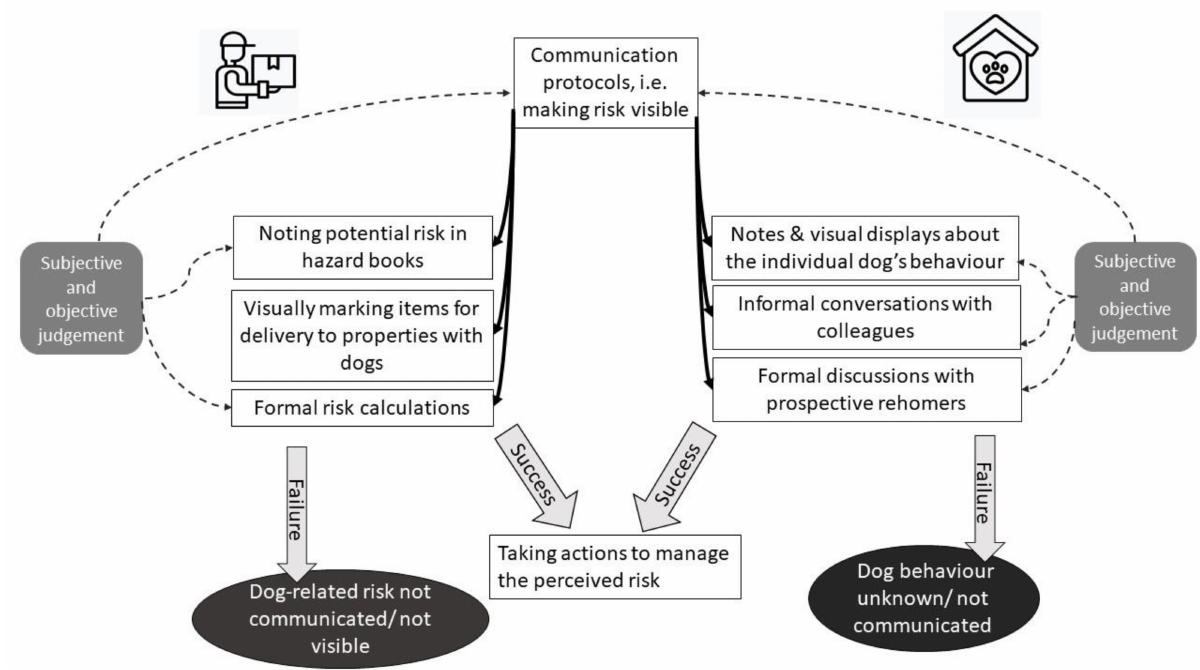
Figure 3. Schematic representation of the second step of dog bite prevention: communicating risk to others. In both delivery companies and dog shelters communication protocols rely on subjective and objective judgement of risk, however the specific protocols for communication differ between the organisations. Successful communication enables taking actions to manage the perceived risk. Risk is not made visible to others when it is not communicated or not